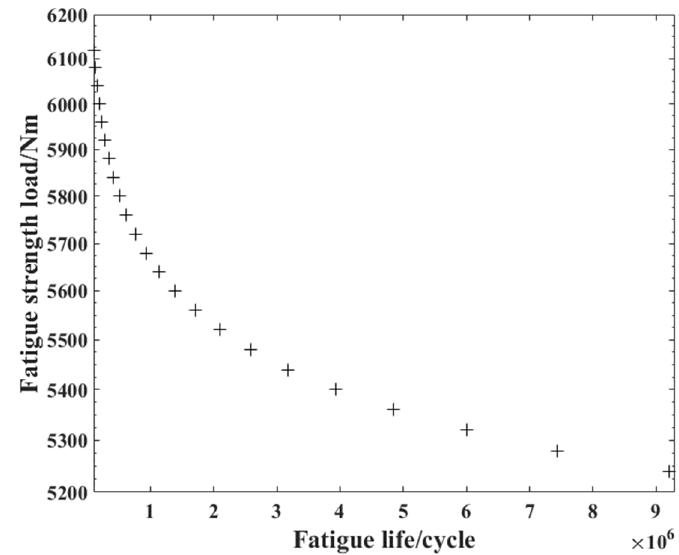
Figure 18. The load-life relationship of crankshaft N1.